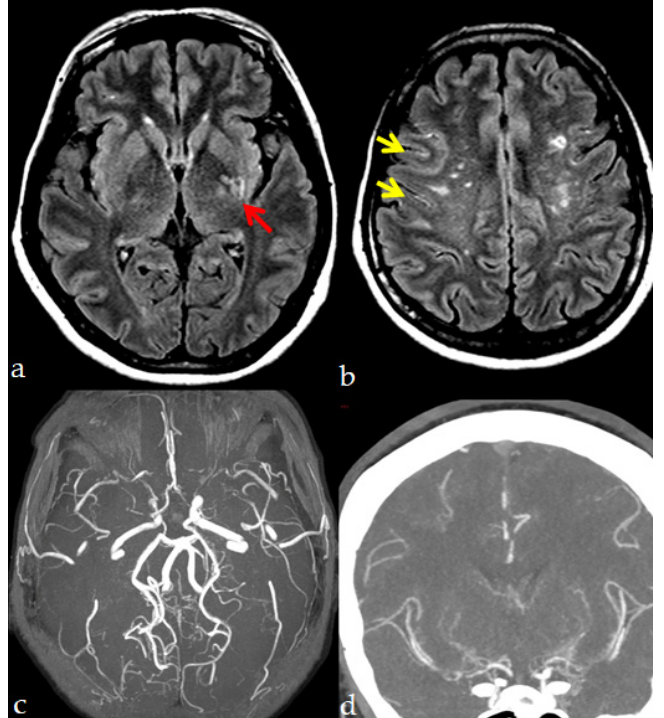
Figure 1. MRI and CT imaging assessment in an MMA patient. Axial FLAIR images show ( a ) a small lacunar infarction in the left posterior lenticular region, which is pointed out by the red arrow; ( b ) multiple, non-confluent, white matter hyperintensities with subcortical distribution in both hemispheres; yellow arrows indicate the Ivy sign. ( c ) MRA with bilateral terminal ICA steno- occlusion with lack of signal in both M1 MCA. ( d ) CTA in coronal MIP showing the same finding as in ( c ) with visualization of the distal sylvian segment of MCA and prominent collateralization in the lenticulostriatal perforator vessels. (Imaging performed at the Neuroradiology Department, AUSL Reggio Emilia; pictures are reproduced with patient’s permission).